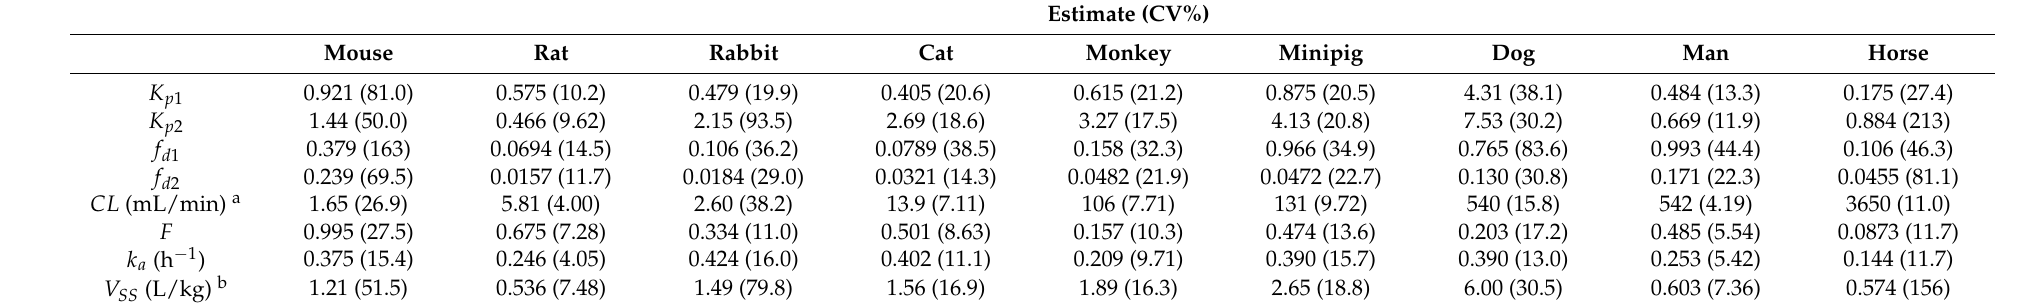
Table 4. Pharmacokinetic parameters of metformin separately fitted to the minimal physiologically based pharmacokinetic model across 9